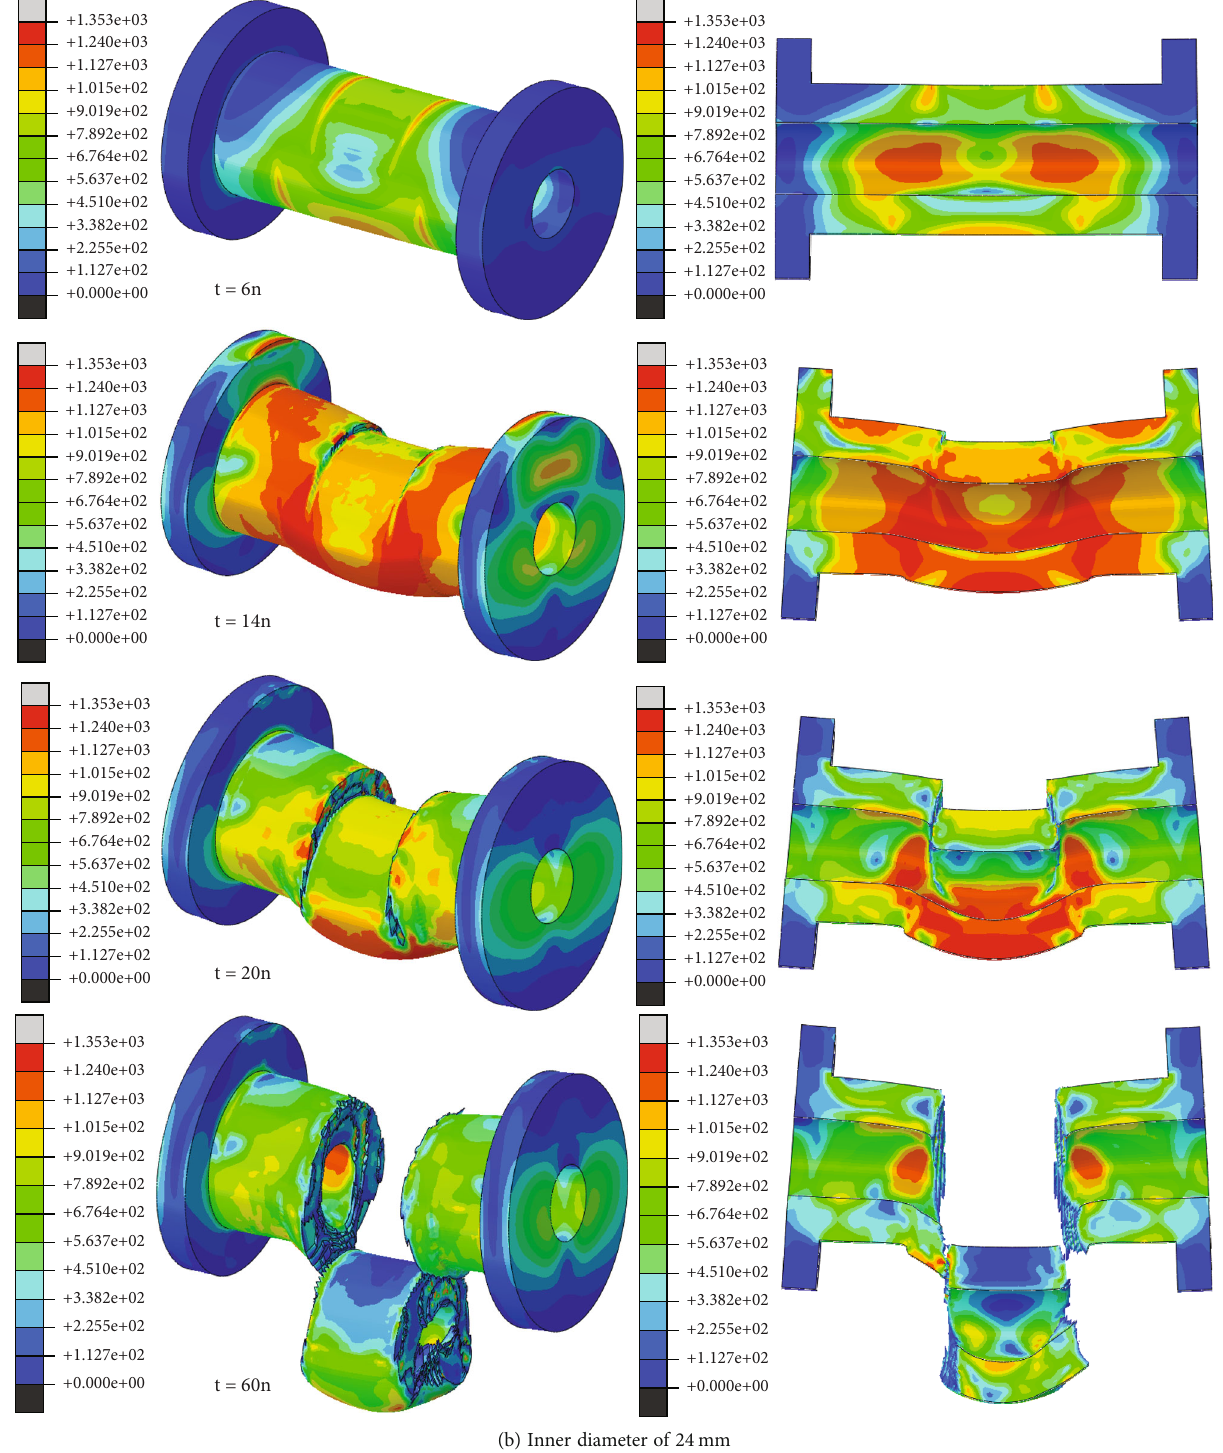
(b) Inner diameter of